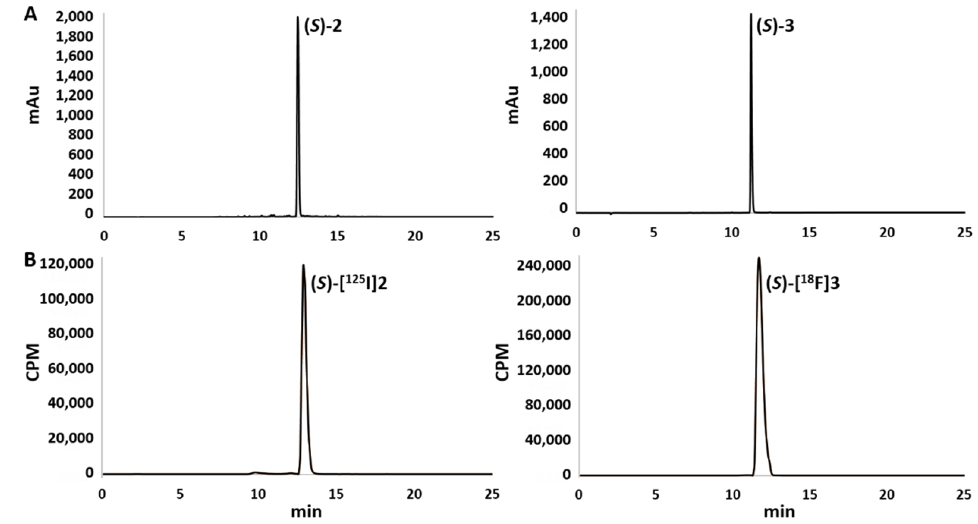
Figure 6. ( A ): UV-HPLC chromatograms (330 nm) of iodinated and fluorinated reference compounds ( S )- 2 and ( S )- 3 ; ( B ): radioactivity-HPLC chromatograms of the corresponding radiotracers ( S )-[ 125 I] 2 and ( S )-[ 18 F] 3 obtained after semipreparative RP-HPLC purification and formulation. The radioactivity detector was connected in series after the UV detector, which accounts for the slight difference of retention times ( ≈ 0.3 min) observed between 125 I/ 127 I or 18 F/ 19 F products. In the ethanolic solution eluted after the C18 SPE cartridge, as well as in the formulation medium and in Dulbecco’s Phosphate Buffered Saline (DPBS, pH 7.4), the radiotracer was found to be stable over hours at room temperature (RCP: 98.0%, 97.2%, and 97.4%, respectively, at 3 h post formulation, Figure 7). In addition, no significant degradation or deiodination of the radiotracer ( S )-[ 125 I] 2 was detected in mouse serum after incubation for 3 h at 37 °C (RCP: 94.3%).